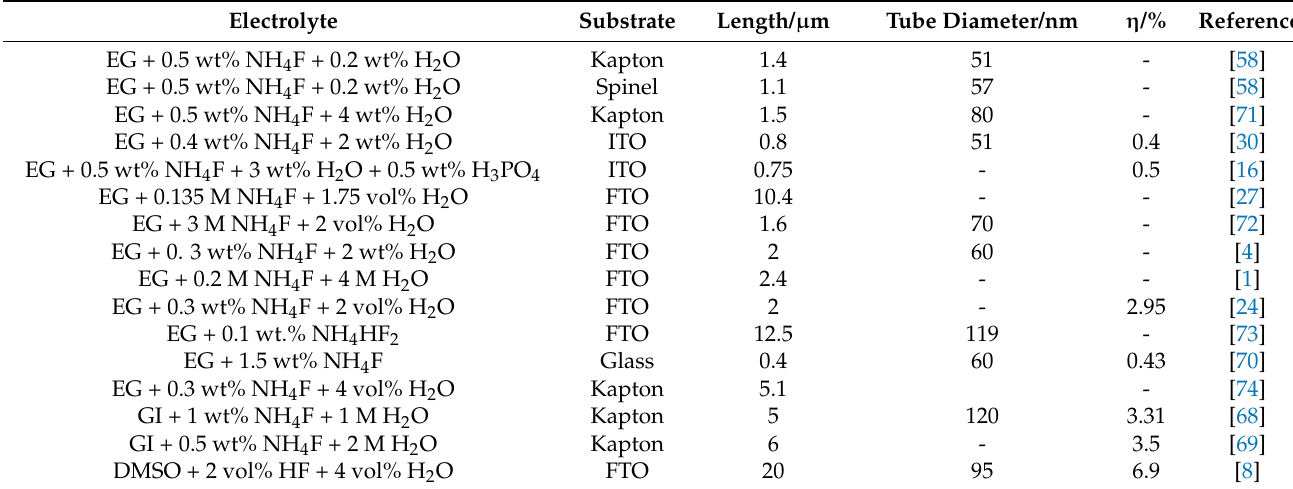
Table 3. Average diameter diameter, length and solar energy-to-electricity conversion efficiency ( η ) of TNTs grown om TCO or polymer